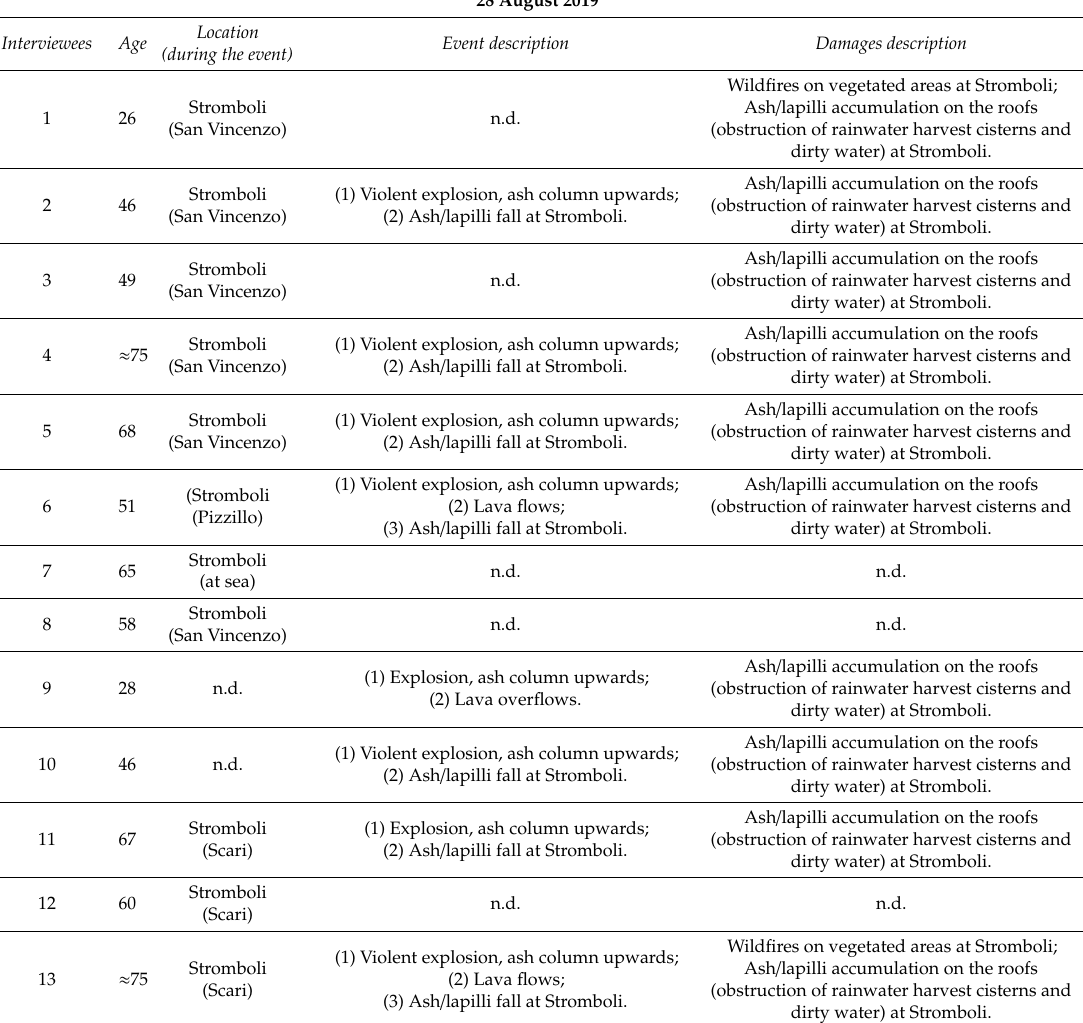
Table A3. Summary of semi-structured interviews to the inhabitants of Stromboli island, after the 28 August 2019